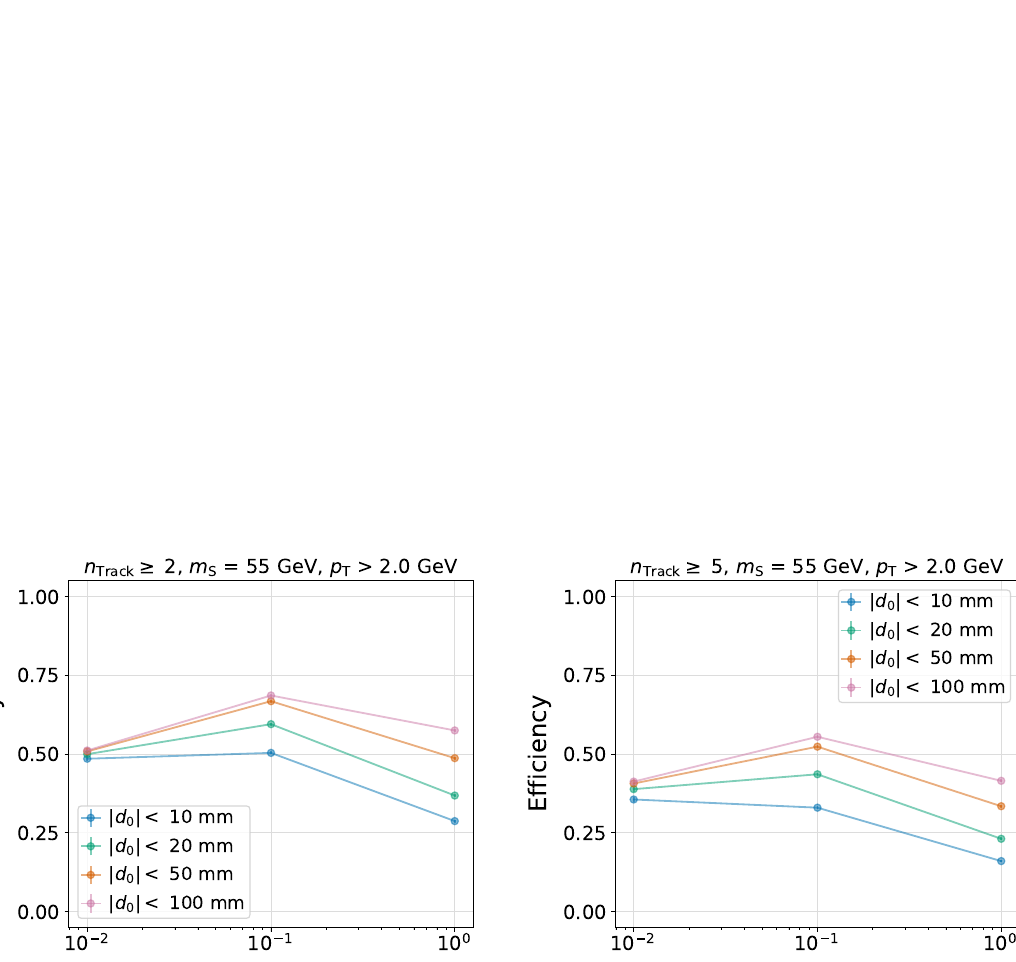
scenarios. Track up until the 0 |